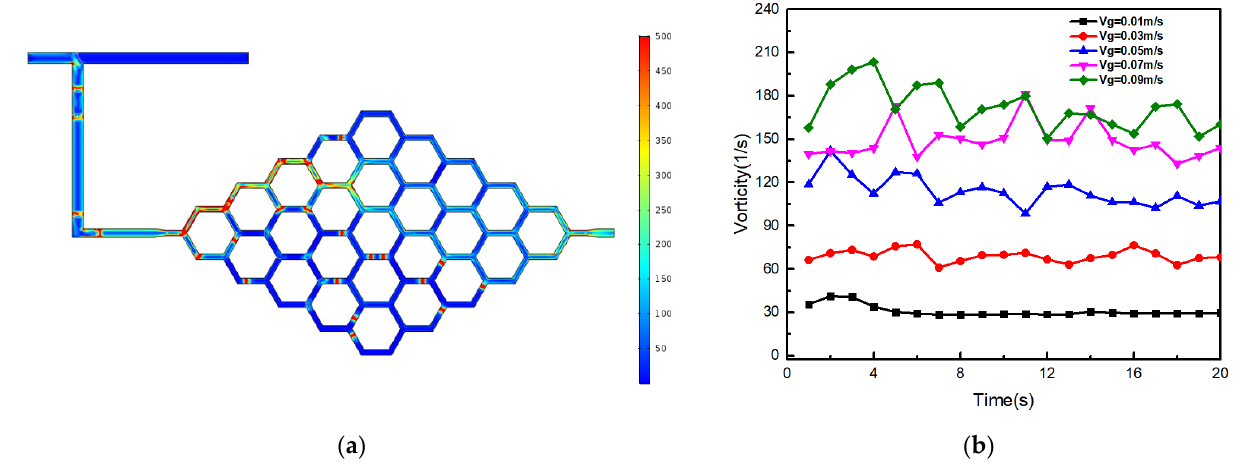
Figure 13. ( a ) The vorticity field distribution contour under condition 3 (t = 7 s), s − 1 ; ( b ) The average vorticity with time under different working conditions.